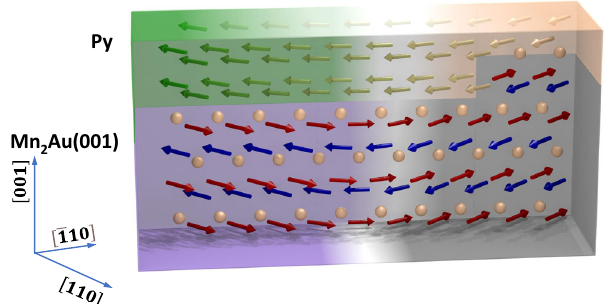
Fig. 5 Magnetic coupling in Mn 2 Au(001)/Py bilayers. This schematic cut through the bilayer shows a side view of two 90 ∘ domains and visualizes the morphological origin of the imprinting of the AFM domain pattern into the FM. Due to the speci fi c interface morphology with a well-de fi ned Au termination, M F is always aligned parallel with N and couples with the same relative orientation, despite the existence of atomic